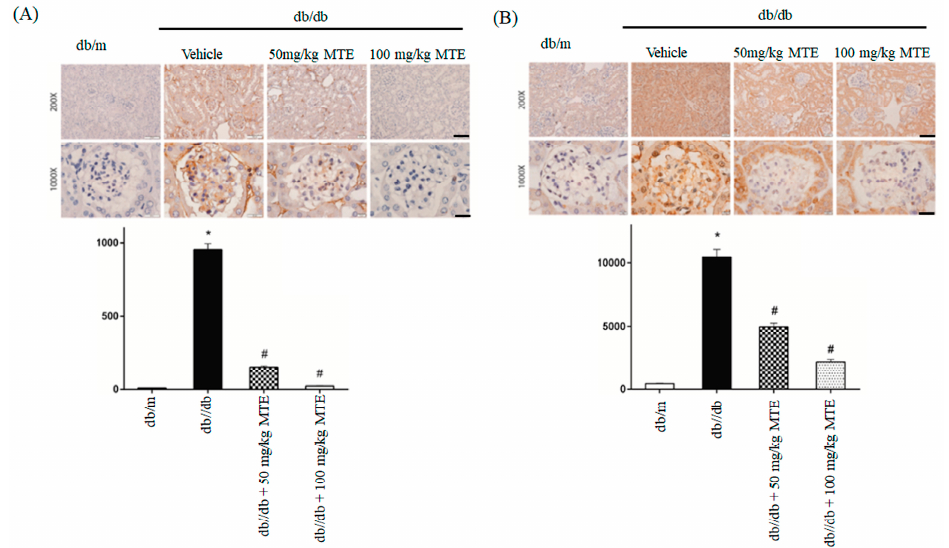
Figure 4. MTE altered the expression of fibrosis-related proteins in diabetic mice. Immunohistochemical staining using anti-fibronectin ( A ) and collagen IV ( B ) antibodies of glomerulus derived from the dd/db mice administered with 0, 50, or 100 mg/kg MTE. db/m mice were used as a negative control. The lower panel represents the means and standard deviation of IDO obtained from six mice. *: p < 0.005 compared with db/m mice. #: p < 0.005 compared with db/db mice without MTE. Scale bar: 100 μ m at 100× and 20 μ m at 1000×.